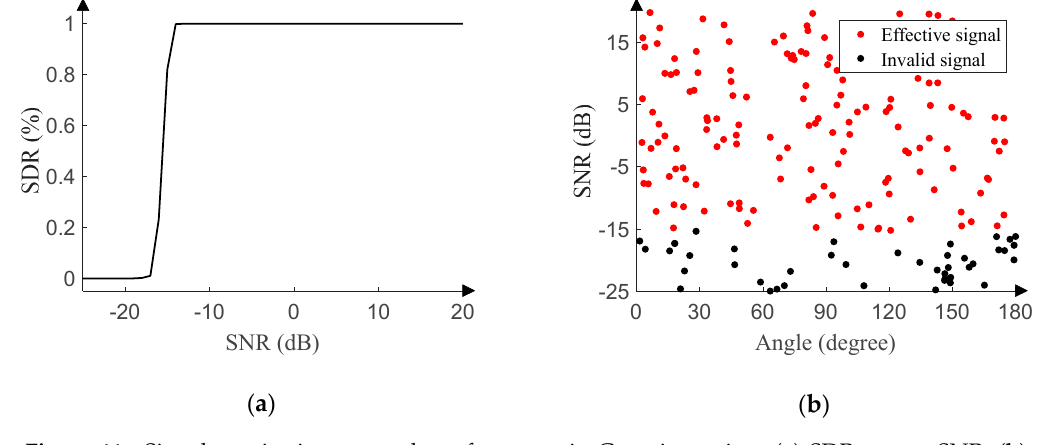
Figure 11. Signal monitoring network performance in Gaussian noise. ( a ) SDR versus SNR. ( b ) Response of the signal monitoring network.